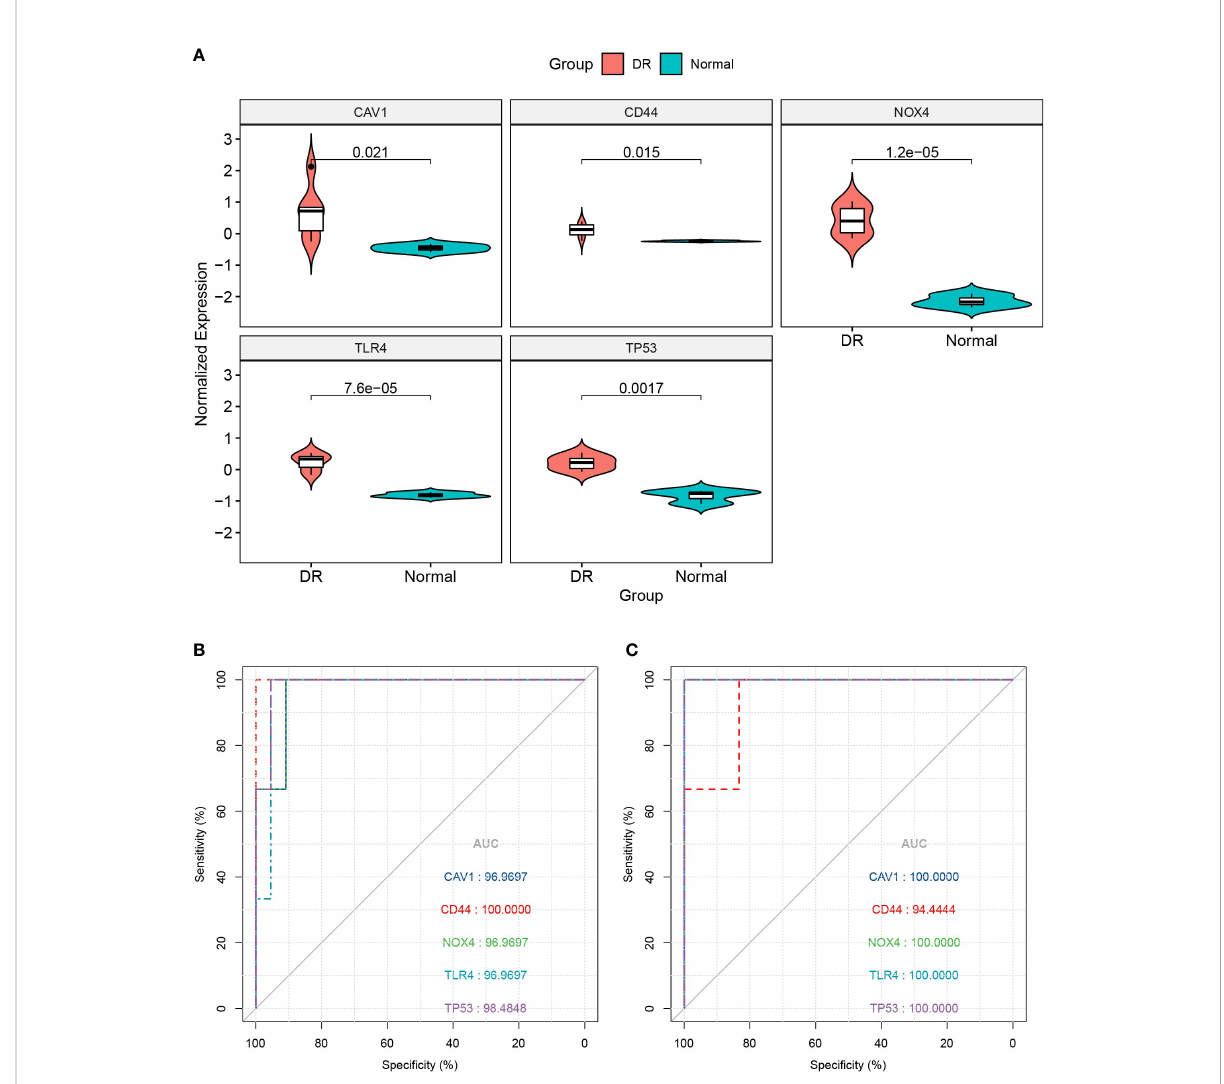
FIGURE 5 Database validation of ferroptosis-related hub genes (FRHGs). (A) Validation of FRHGs in the GSE60436 dataset. (B) ROC curve of FRHGs in the GSE102485 dataset. (C) ROC curve of FRHGs in the GSE60436 dataset. DR, diabetic